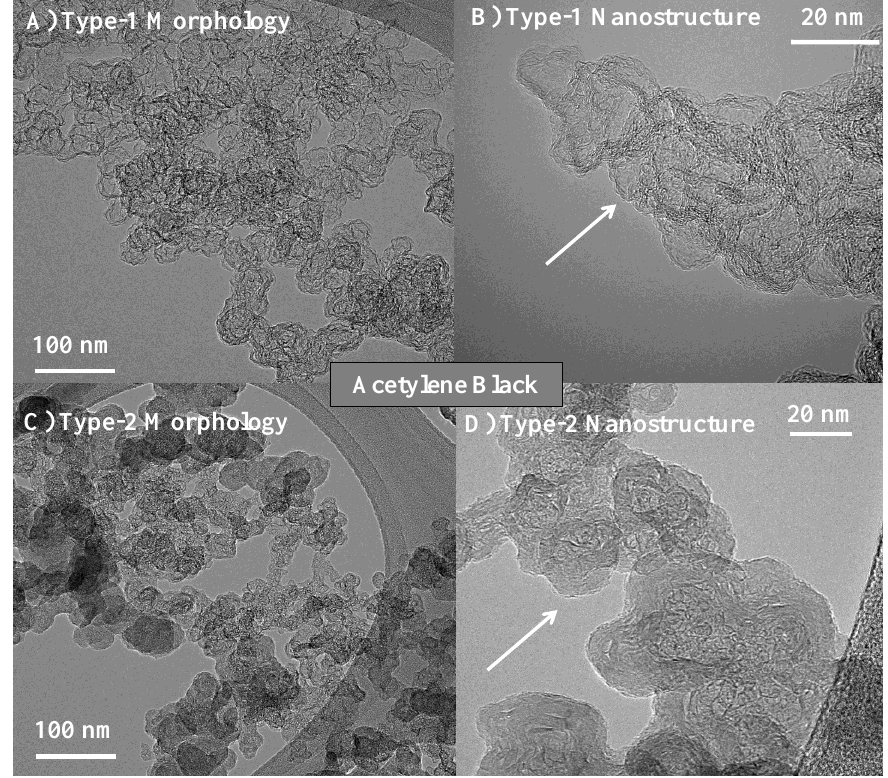
Figure 2. TEM micrographs showing two types of acetylene black. Images ( A,B ) illustrate morphology and nanostructure of type-1 and images ( C,D ) to type-2 acetylene